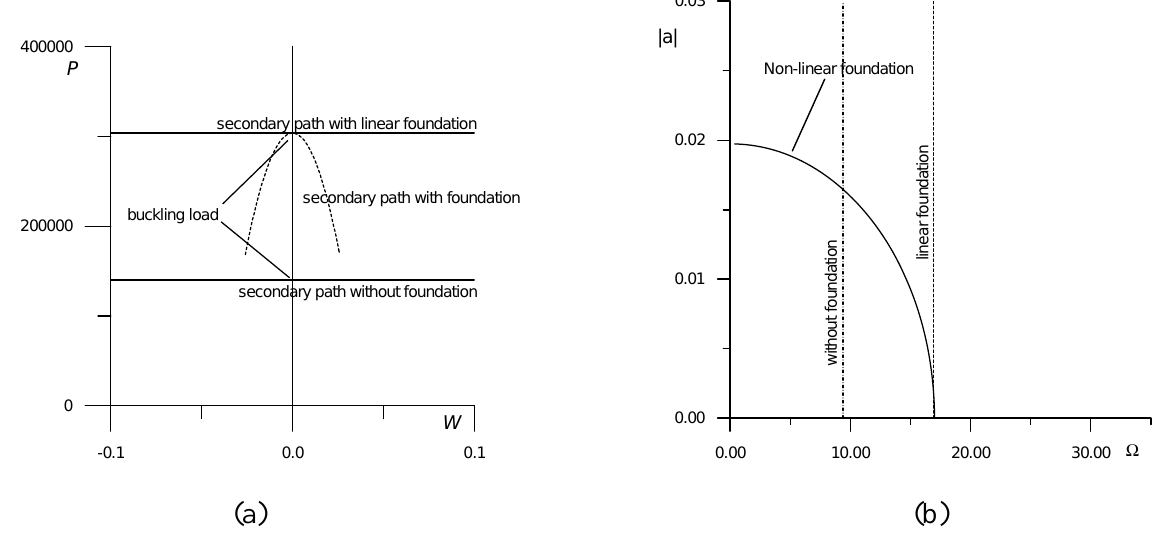
Fig. 3. Influence of the foundation on (a) the buckling and post-buckling behavior of the beam and (b) on the frequency-amplitude relation.